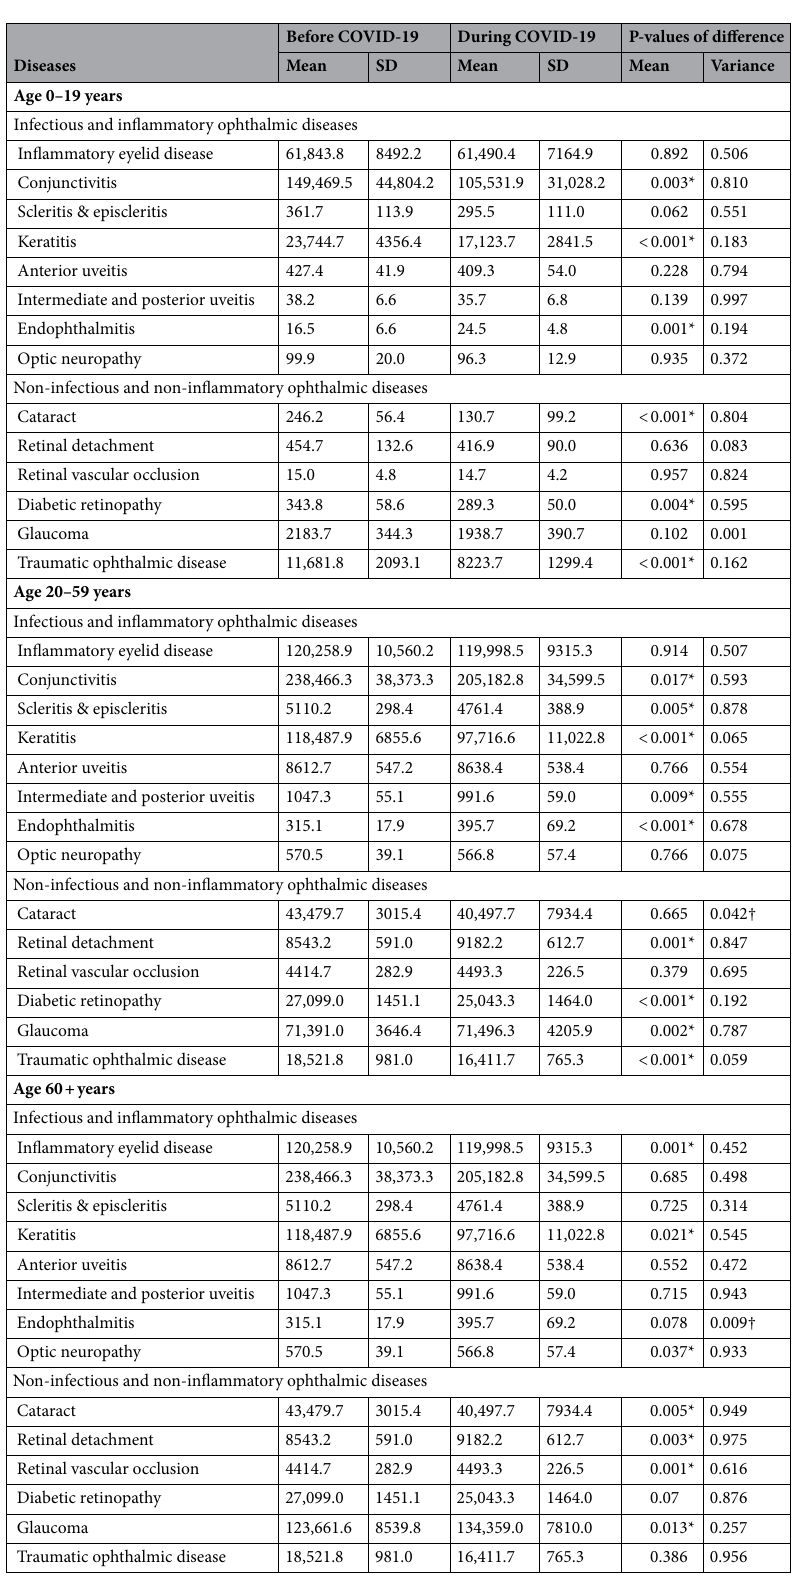
Table 3. Means, standard deviations of disease incidence before and during COVID-19 and their differences by age. *Mann Whitney U test, significance at < 0.05. †Levene’s test for non-parametric data, significance at <